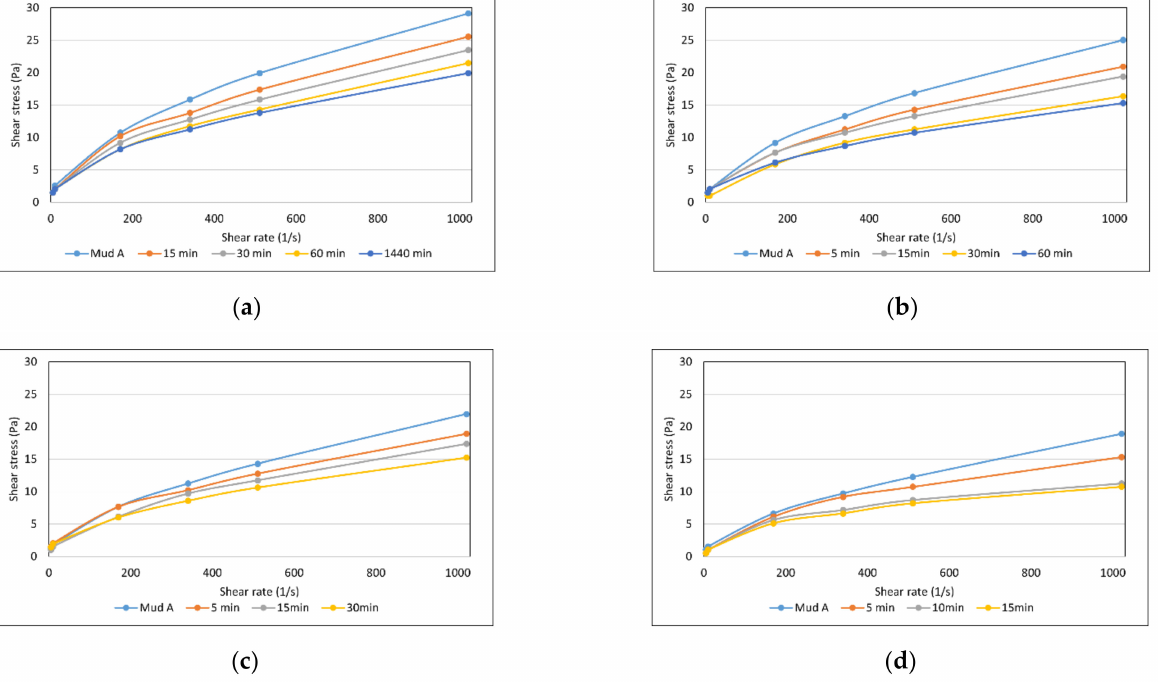
Figure 2. Flow curves of drilling mud A with the addition of 1.0% urea peroxide: ( a ) at 20 ◦ C, ( b ) at 40 ◦ C, ( c ) at 60 ◦ C, ( d ) at 80 ◦